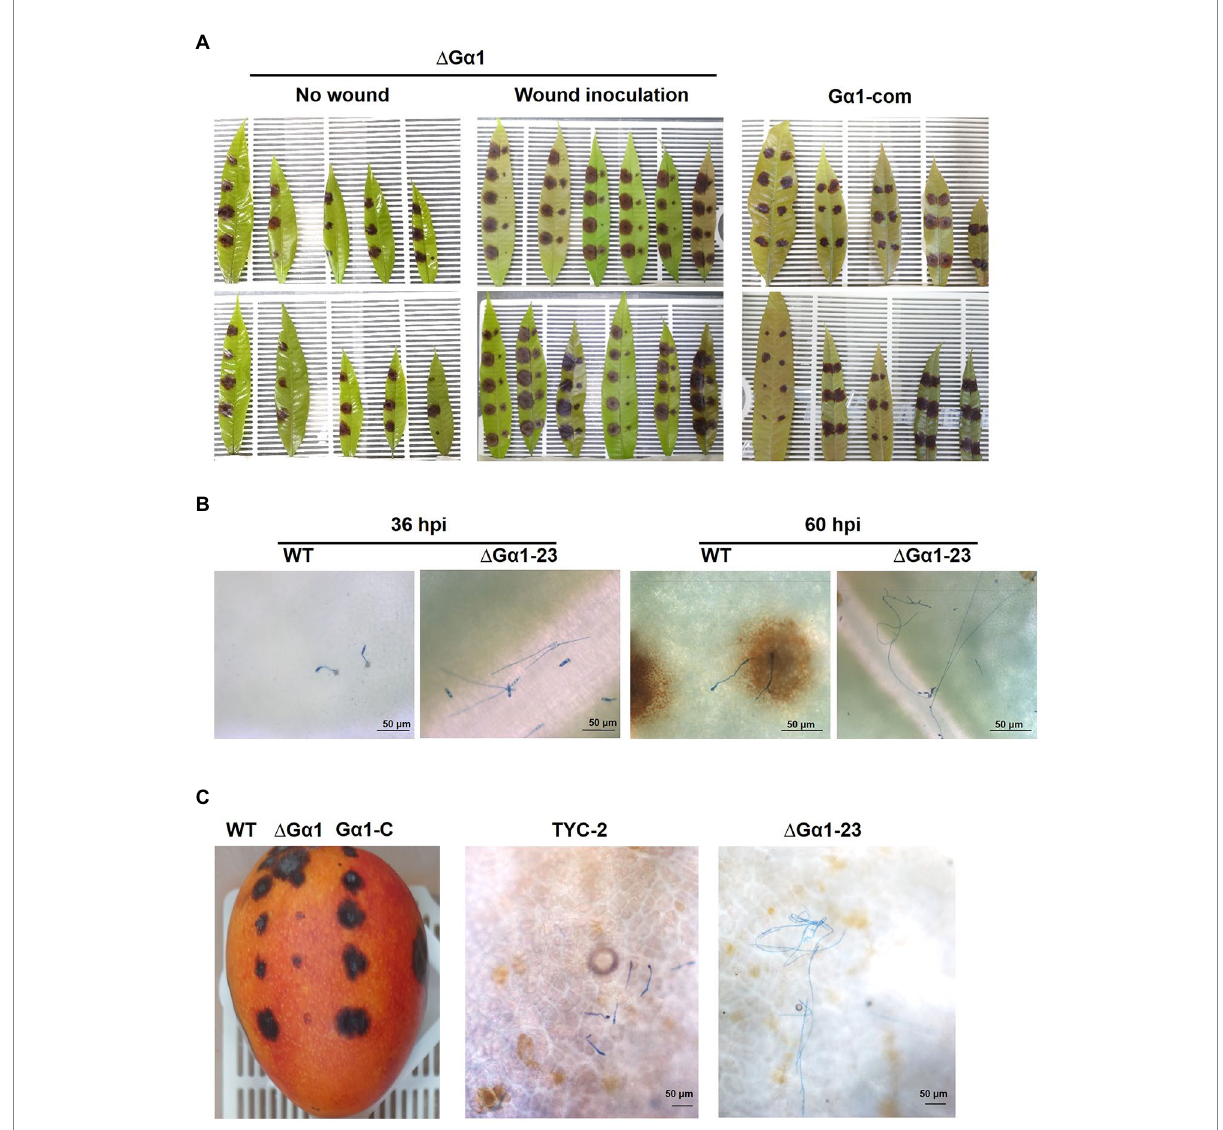
FIGURE 7 Pathogenicity assay of Colletotrichum asianum wild-type strain TYC-2 (WT), G 𝛼 1 mutants ( ∆ G 𝛼 1–2, ∆ G 𝛼 1–23) and gene complementation strain (G 𝛼 1-com) on mango leaf (A,B) and fruit (C) at 4 and 14 days postinoculation, respectively. On mango leaf, TYC-2 was inoculated on the left side and a mutant or a gene complementation strain was inoculated on the right side of the same leaf (A) . Spore germination and hyphal growth on the leaf surface were presented at 36 and 60 h postinoculation (hpi) (B) and on the mango fruit surface at 48 hpi (C)